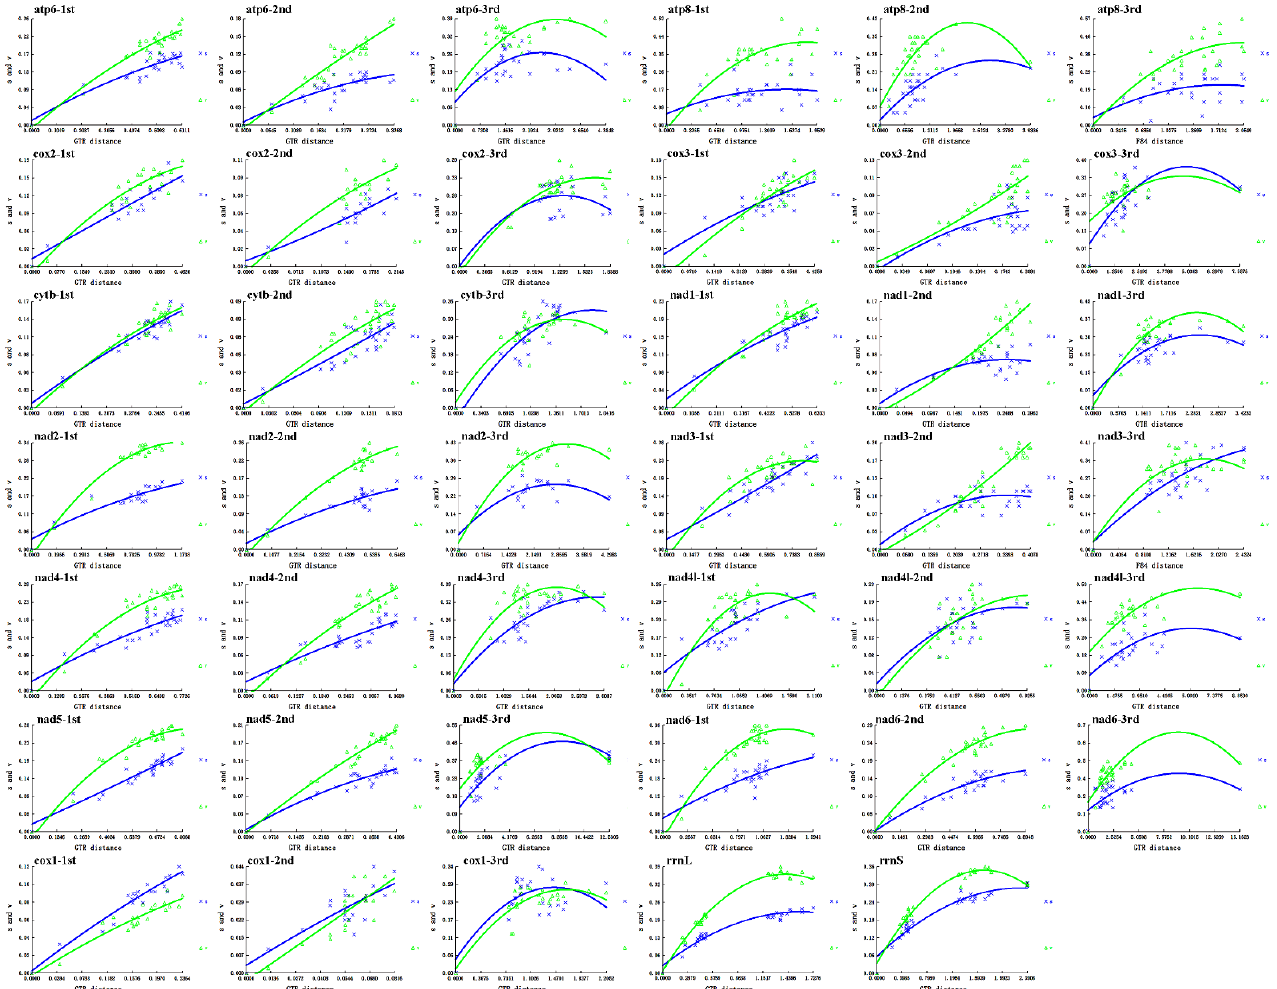
Figure 5. Substitution saturation plots per codon position for PCGs and per gene for rRNA. The plots of cox1 were calculated excluding the partial cox1 sequence of Diplatys flavicollis .